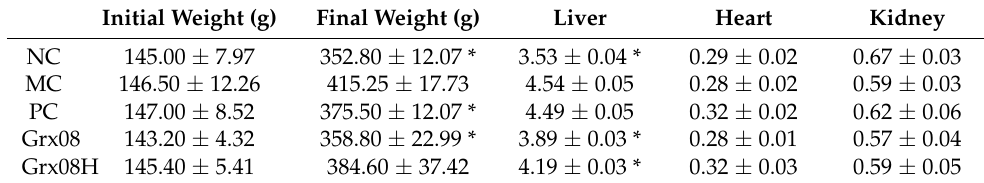
Table 1. Body weight and organ index of rats.